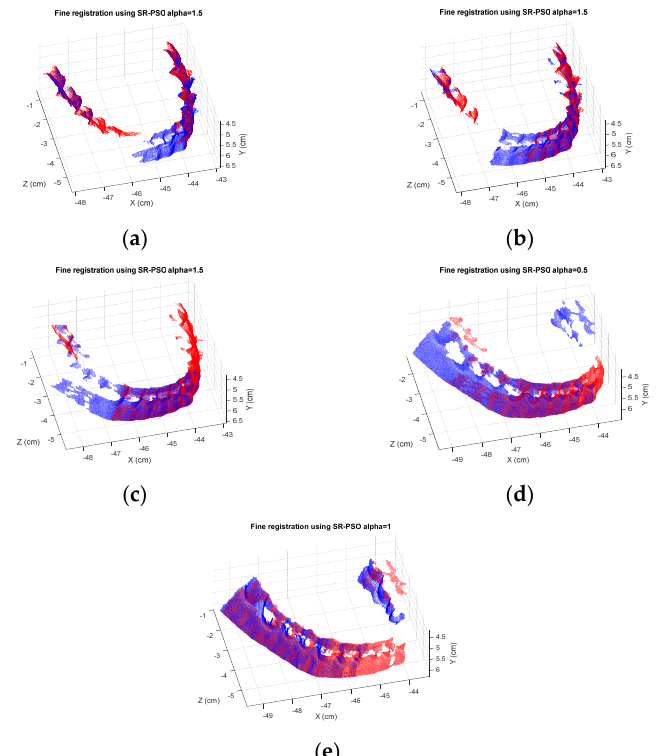
Figure 12. The best SR-PSO registration results for the pairs ( a ) 1 and 2; ( b ) 2 and 3; ( c ) 3 and 4; ( d ) 4 and 5; ( e ) 5 and 6 of the orthodontic-tooth model.